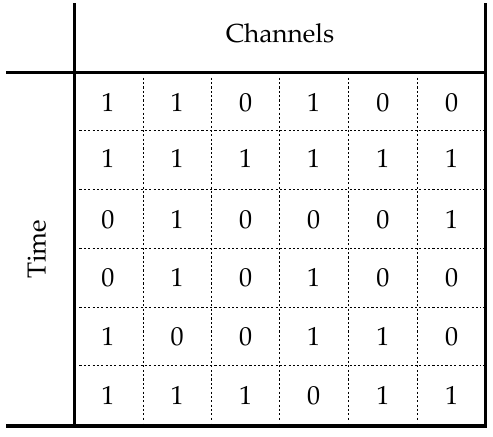
Figure 6. Availability matrix.